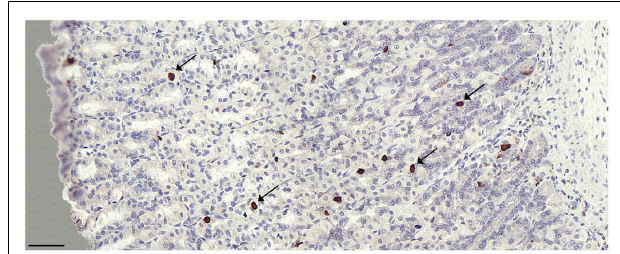
FIGURE 1 | Immunohistochemical photomicrograph of X/A-like cells in the rat gastric oxyntic mucosa of ad libitum fed male rats. Ghrelin-positive X/A-like cells (arrows) are evenly distributed throughout the entire length of the gastric oxyntic glands.The scale bar represents 50 μ